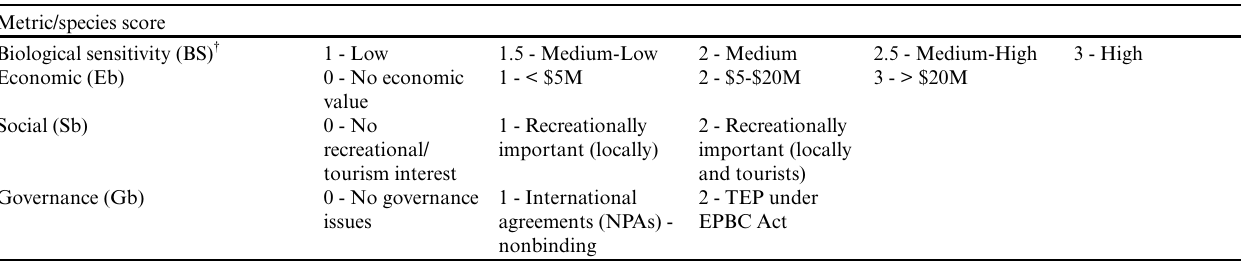
Table 4 . Metrics used in the calculation of the biological sensitivity (BS) and the integrated species exposure (ISE=Eb+Sb+Gb) for individual species. Economic, social, and governance categories were taken from IPCC (2007) report. NPA = National Partnership Agreements, TEP = Threatened, Endangered and Protected species, EPBC = Environment Protection and Biodiversity